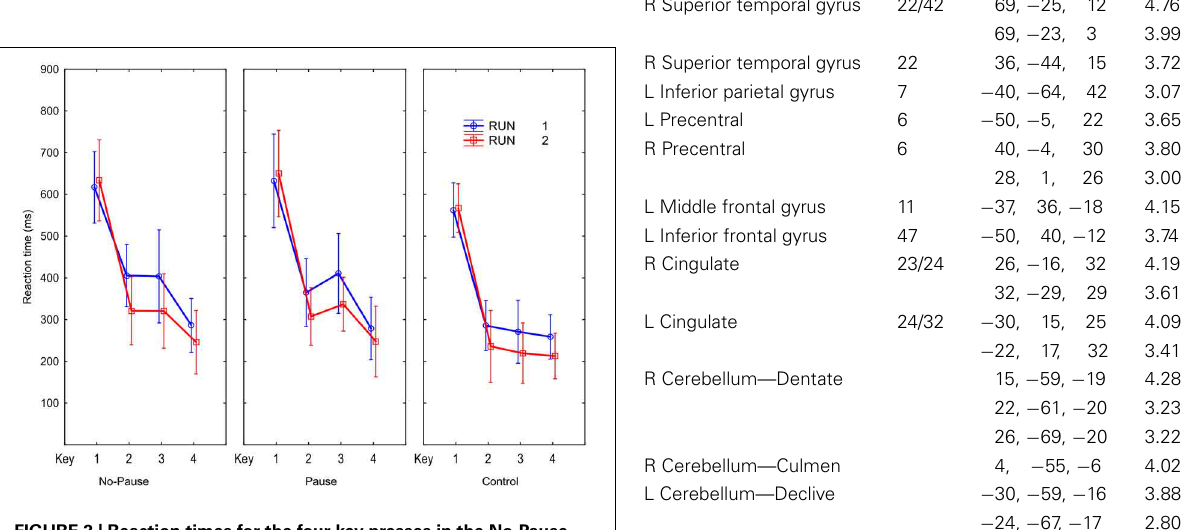
FIGURE 2 | Reaction times for the four key presses in the No-Pause, Pause, and Control conditions for the two Novel sequence runs during